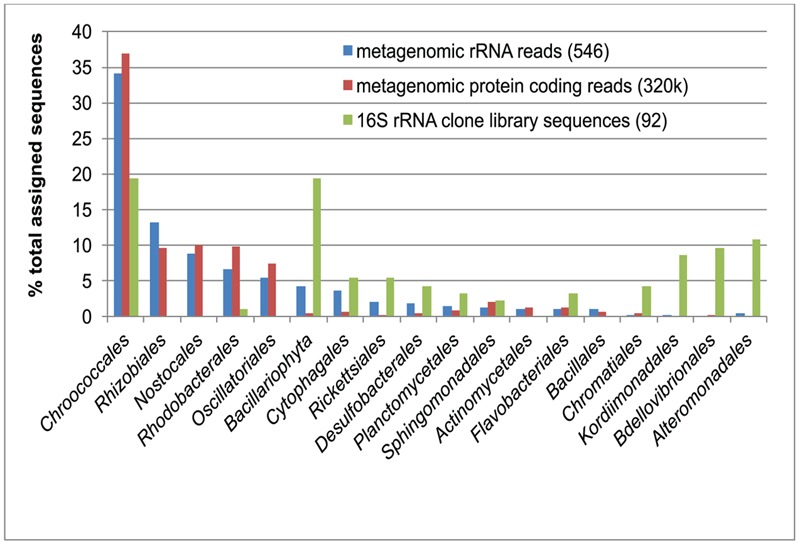
Comparison of green berry bacterial diversity estimates from16S rDNA PCR amplified clones library (green bars; 92 clone sequences) with unassembled Roche 454 metagenomic sequence reads. Taxonomic assignment of metagenomic reads matching ribosomal RNA reads (16S/18S/23S) was conducted using the M5RNA database in MG-RAST (blue bars; 546 assigned reads). A similar taxonomic assignment was conducted with metagenomic reads matching protein coding sequences in the M5NR database (red bars; 319,692 assigned reads). Note that the 16S rRNA clone library abundance data for the Bacillariophyta (green bar, asterisk) was obtained from diatom chloroplasts sequences, which are likely present in multiple copies in the cell and thus not directly comparable to metagenomic 18S rRNA sequences for this group (blue bar).